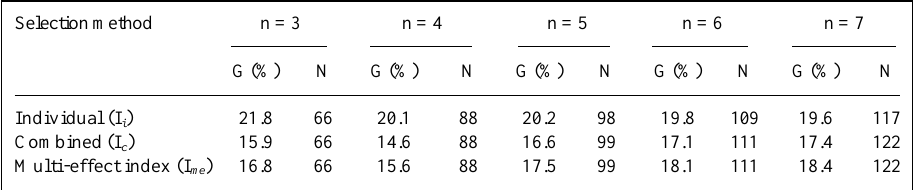
Table IV - Estimates of genetic gain (G) and total number of individuals selected (N) for different selection methods, based on a restricted number (n) of selected individuals per progeny. The effective population size for rubber production was restricted to